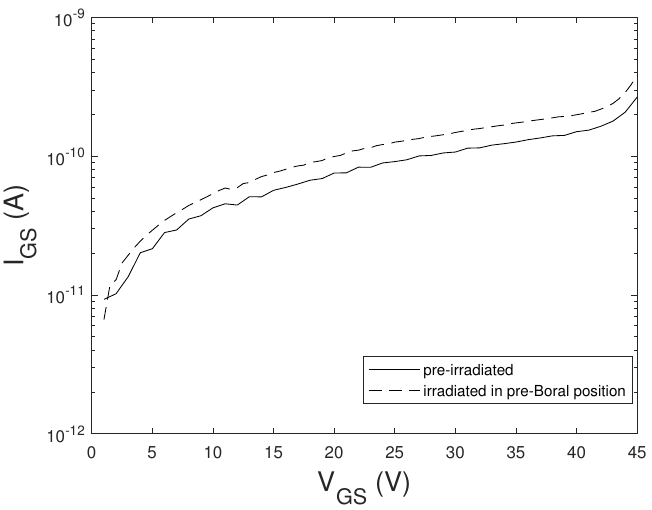
Figure 4. I GS − V GS curves at V DS = 0 V of a I_B IGBT sample before and immediately after irradiation with thermal and fast neutrons (pre-Boral position) with V GS = + 40